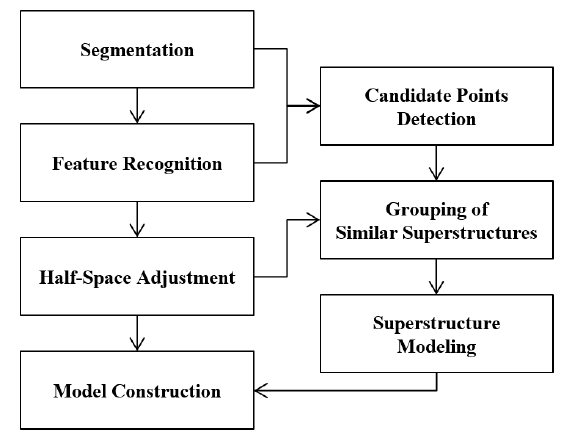
Figure 2. Overview of the proposed reconstruction approach of regularized superstructures in low-density point clouds that has been integrated in the building reconstruction approach presented in (Wichmann and Kada, 2014).